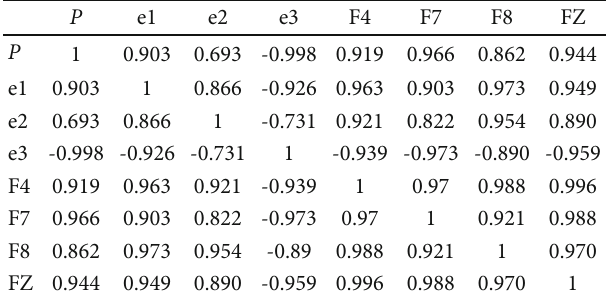
Table 6: Frequency table of eye movement test evaluation.